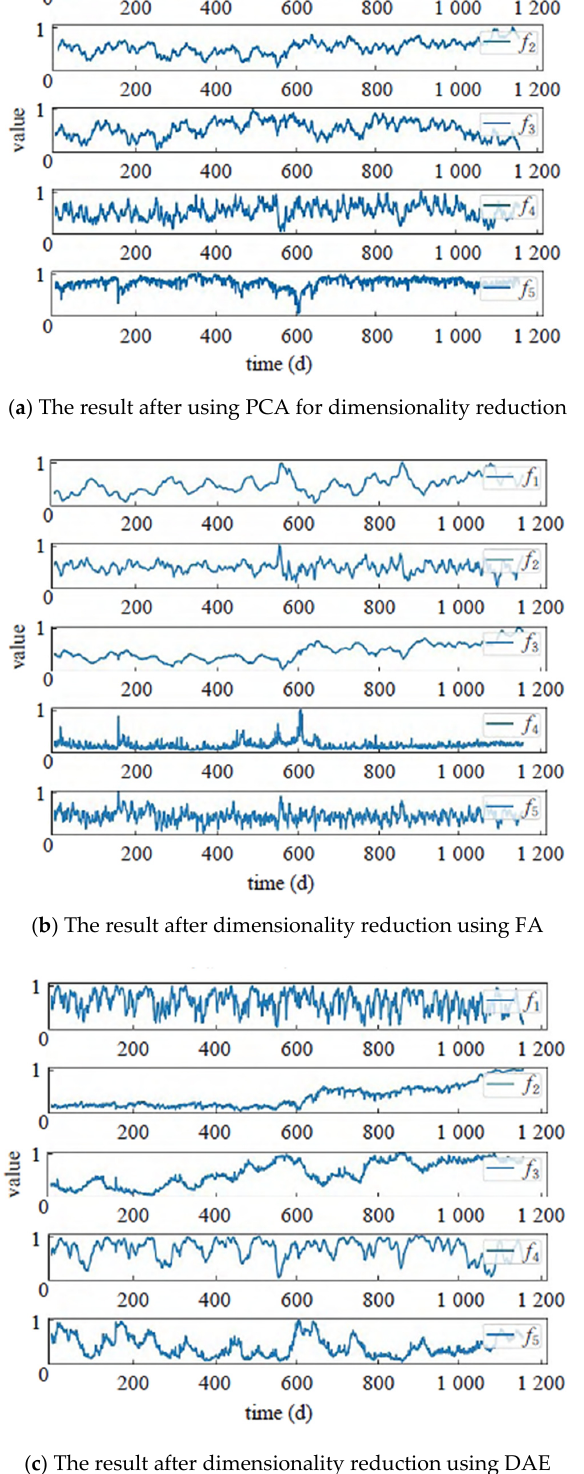
Figure 6. Coding sequence of stock data after dimensionality reduction.